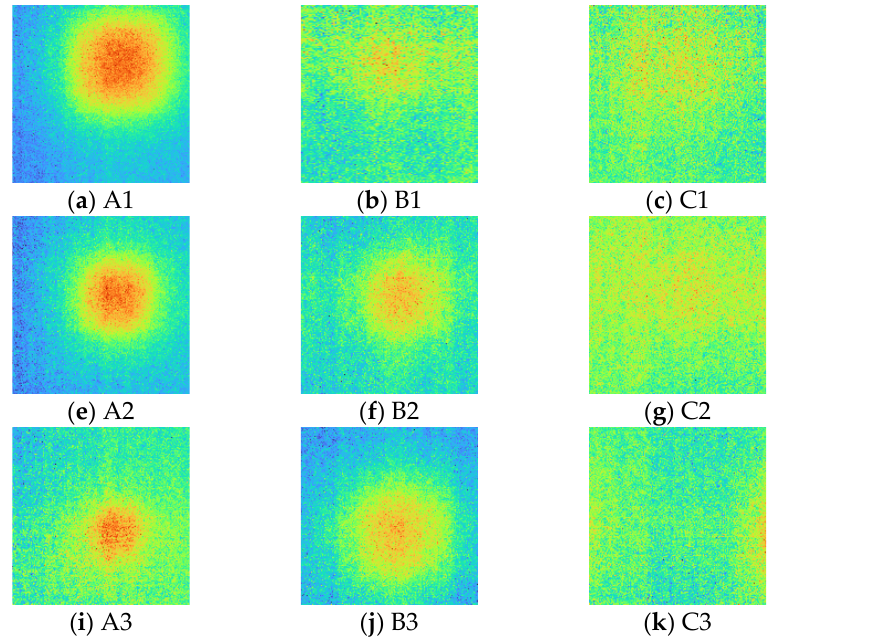
Figure 10. Segmentation image for phase data at 0.01 Hz.